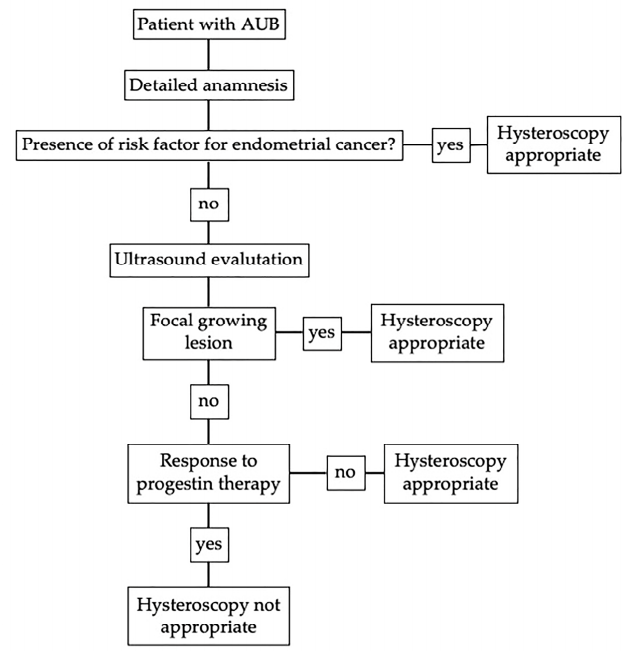
Figure 3. Diagnostic algorithm without age criteria for patient with abnormal uterine bleeding (AUB) in fertile and pre-menopausal age.